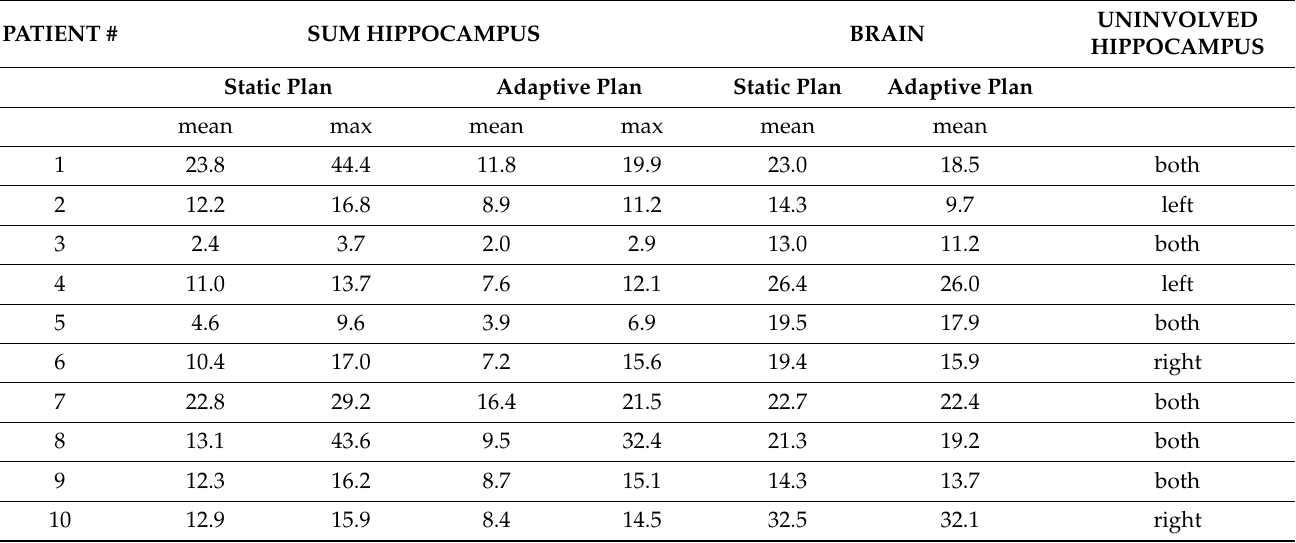
Table 1. Static vs. adaptive plans for all patients. Mean and maximum (max) dose to hippocampus and brain. All numbers shown are in units of Gy.